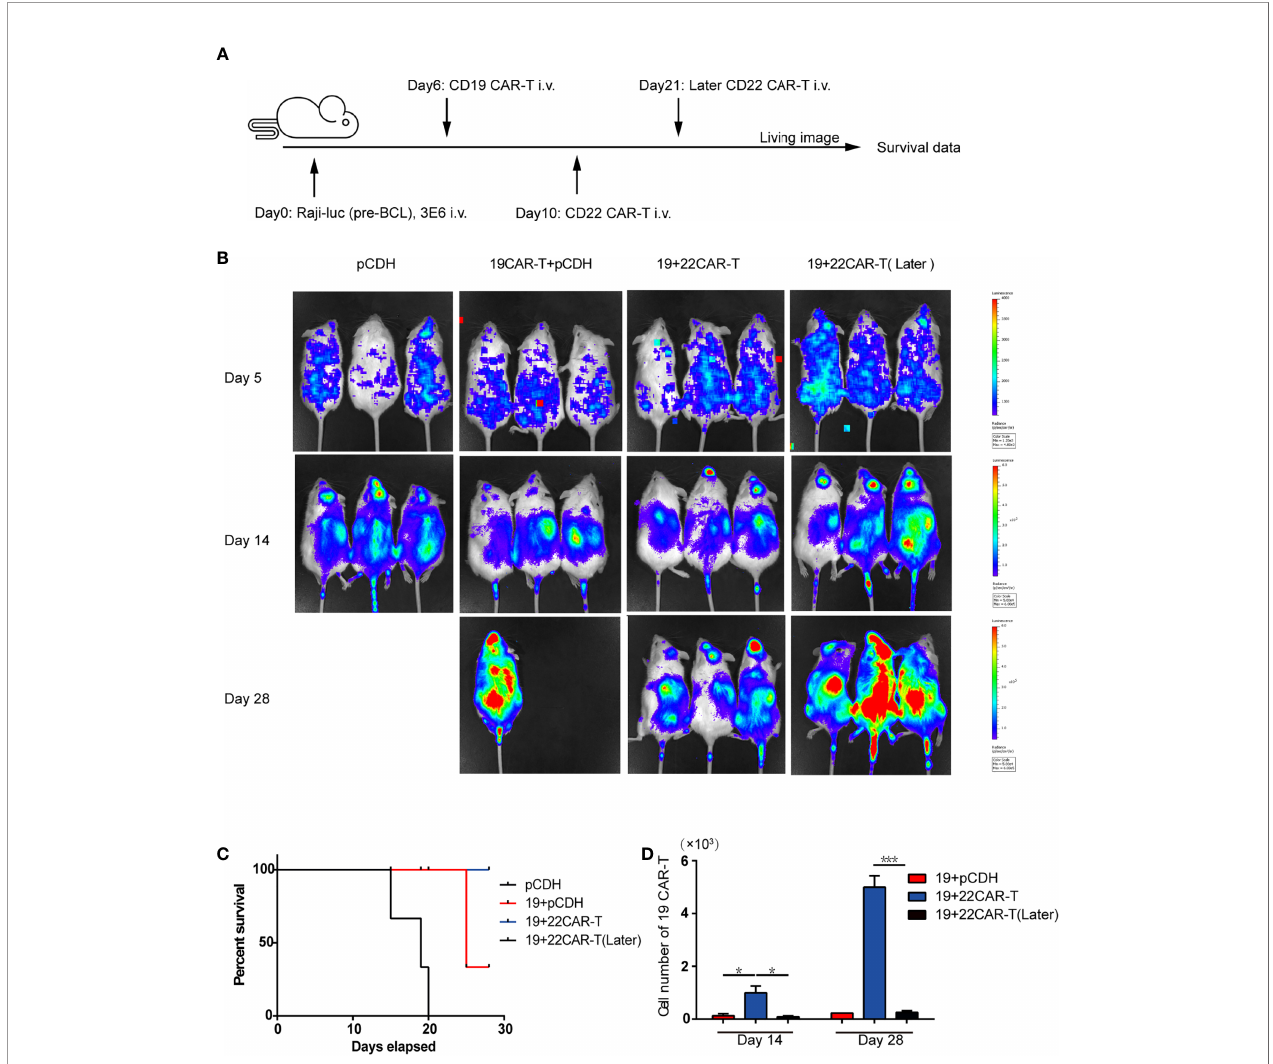
FIGURE 2 | Enhanced antitumor effects after sequential administration of CAR-T cells in vivo . (A) In vivo treatment scheme. (B) Tumor burden measured by bioluminescence. (C) The overall survival. (D) The number of the prior CD19 CAR-T cells was counted before and after secondary CAR-T infusion on days 14 and 28, respectively. *P < 0.05, ***P < 0.001 compared with the control group. Standard error means (SEM) are indicated as error